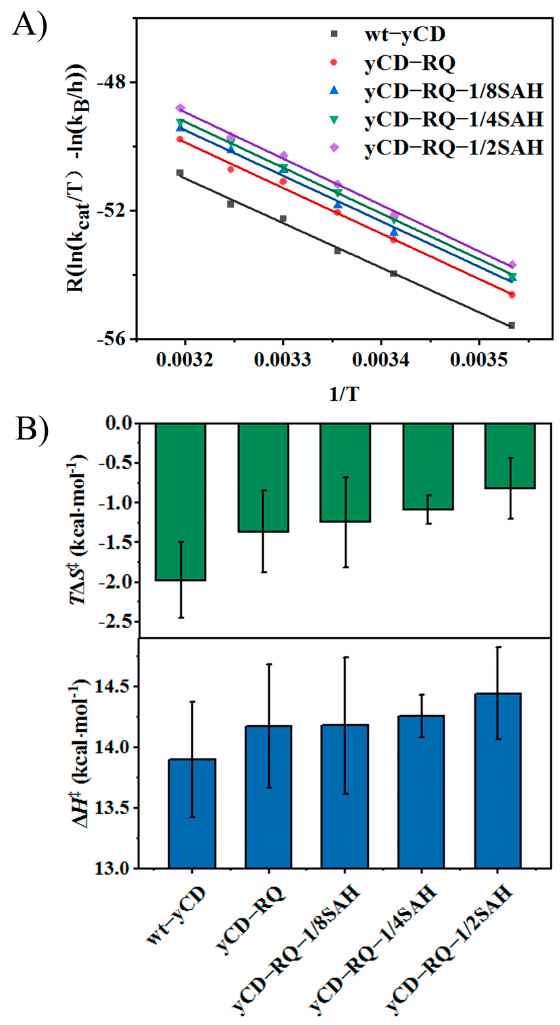
Figure 4. Activation enthalpy ∆ H ‡ and entropy ∆ S ‡ from the Eyring equation: ( A ) Eyring plot of the catalytic rate constant k cat for the substrate 5-FC; ( B ) ∆ H ‡ and T ∆ S ‡ obtained from the linear fitting. Both ∆ H ‡ and T ∆ S ‡ increase as the C-terminal helix is extended, suggesting that the higher catalytic activity of yCD fusion proteins is driven by increased activation entropy. The error bars in panel ( A ) are standard deviation from triplicate experiments. The error bars in panel ( B ) are from the goodness of linear fitting in panel A .